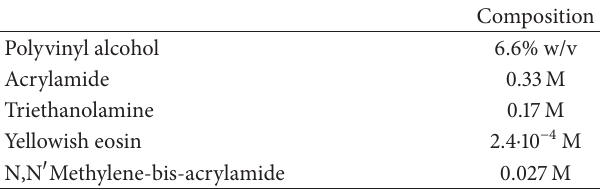
Table 1: Concentrations of the photopolymer composition.